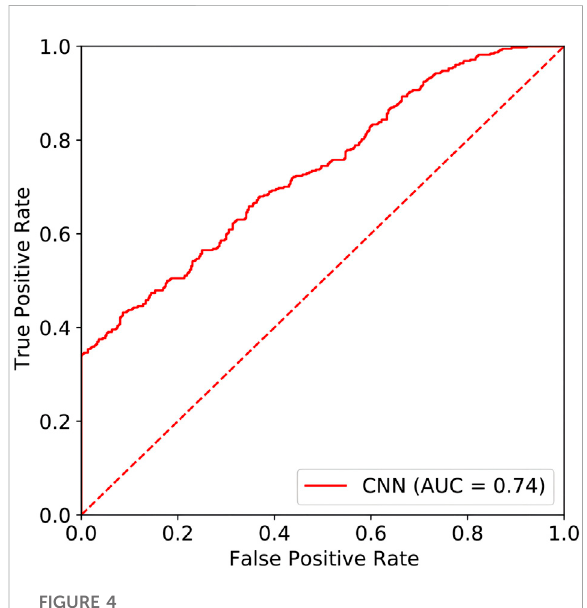
FIGURE 4 ROC of the EEG-based CNN in depression diagnosis.